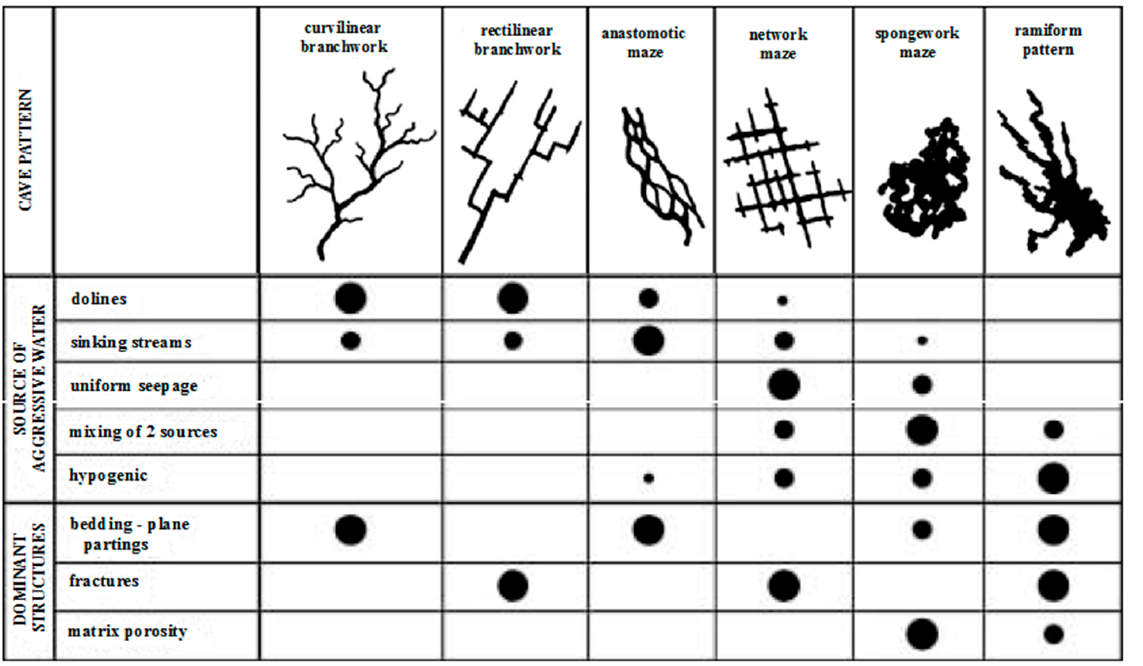
Figure 2. Common patterns of dissolution conduits in carbonate rocks. The size of the black circles shows the relative abundance of cave types in each of the listed categories [25].